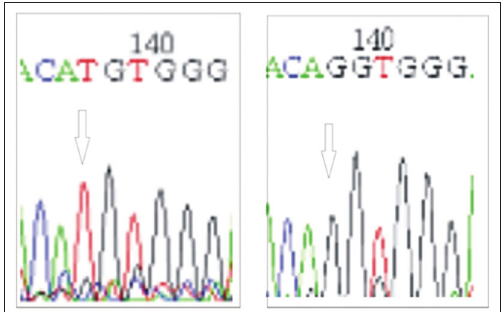
FIGURE 1. Mutation detection in exon 4 of a proband (right) in comparison to wildtype homozygote (left). Thymine on the 667 place of coding sequence is altered to Guanine, which corre‑ sponds to TGT to GGT code